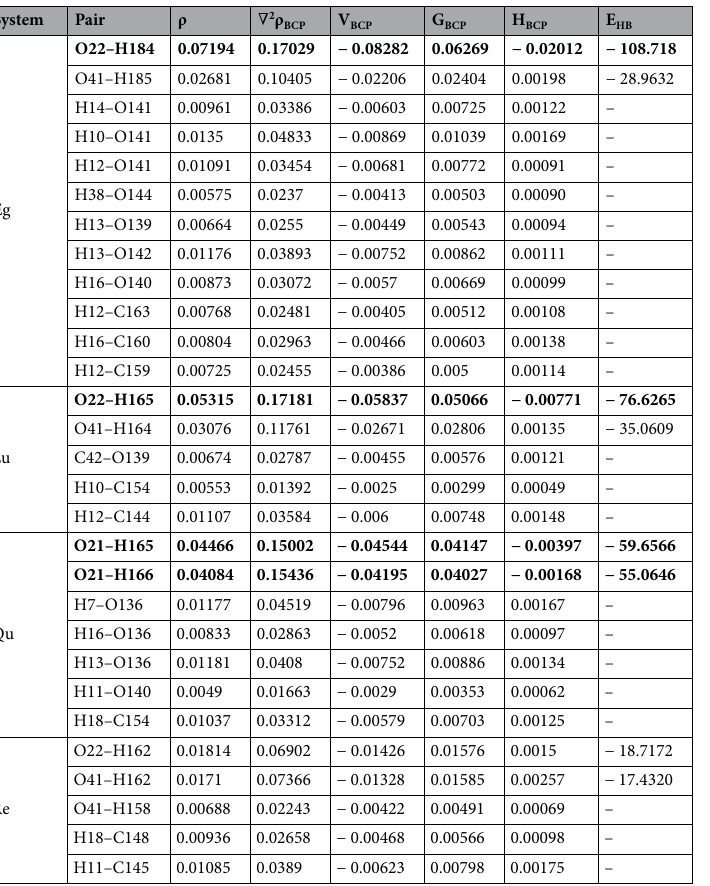
Table 1. The electron densities (ρ), its Laplacian ( ∇ 2 ρ), kinetic electron density (G), the local potential electron energy density (V) and the total electron energy density (H) (all in a.u.), the hydrogen bond energy (E HB , kJ mol −1 ) between PPsand PC. The strong hydrogen bonds show in bold